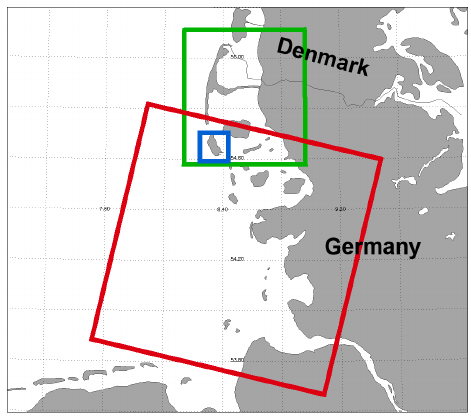
Figure 1: The area of interest: The German Bight (North Sea) showing the northern part of the Wadden Sea. red: image acqui- sition area of the used data, green, boundary of the ENC, blue: ROI used for this work (around the island of